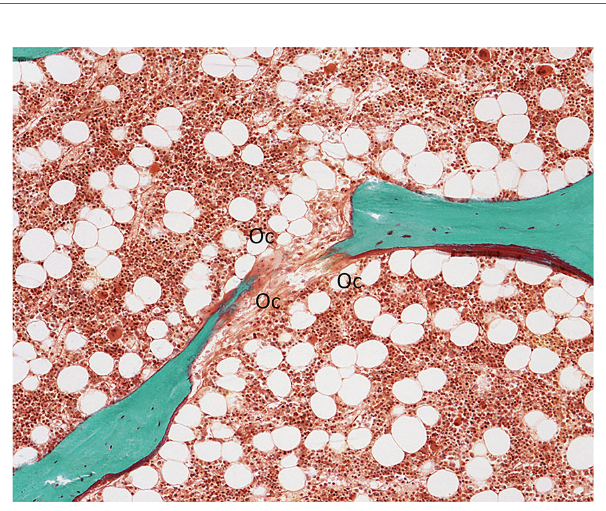
FIGURE 6 | Trabecular perforation due to osteoclastic (Oc) resorption. Goldner trichrome;